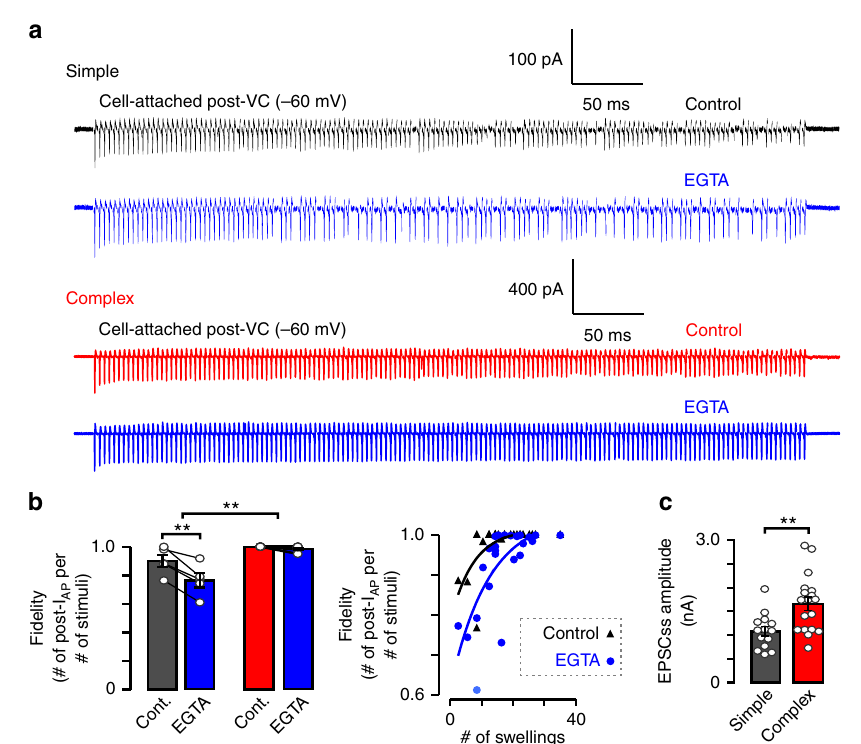
Fig. 7 Postsynaptic spiking is less reliable and more sensitive to EGTA in simple calyces. a Representative pre- and postsynaptic cell-attached recordings of simple (black) and complex (red) calyces show spiking in response to axonal stimulation (300 Hz, 500 ms) before (control) and after presynaptic EGTA loading (blue; 10 mM, 3 – 5 min). b Bar graphs summarize fi delity (number of successful postsynaptic compound action potential currents [post-I AP ]